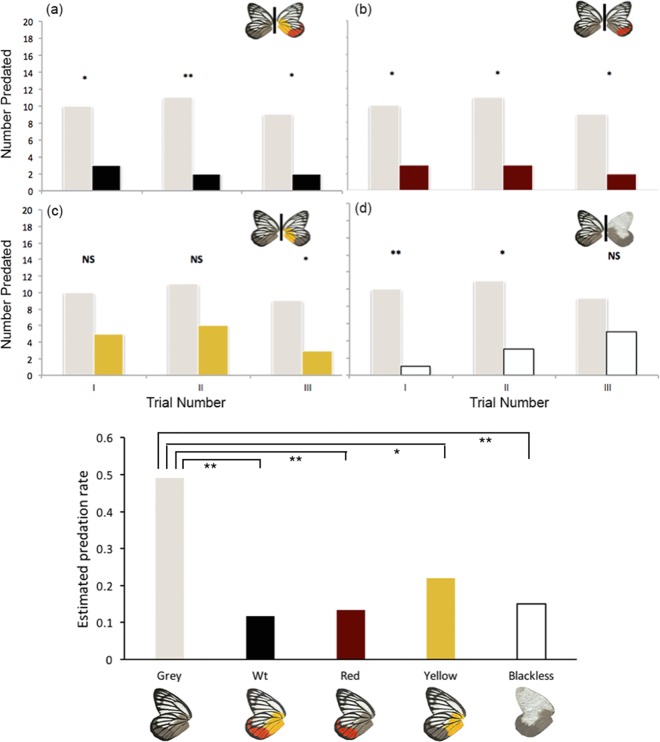
Number of predated test models relative to Grey models in each of the three trials and estimates of predation for each model type.(a-d) Asterisks represent the p-values from Fisher’s exact test (two-tailed) testing for differences in predation between the two model types. (e) Estimated predation rates for each model type across the three sites obtained from a generalised linear mixed-effects model (GLMM) analysis followed by post-hoc pair-wise comparisons (Tukey corrected). Only significant differences are indicated in the graphs. In both tests: *, p < 0.05, **, p < 0.01 and NS, not significant (p < 0.05).